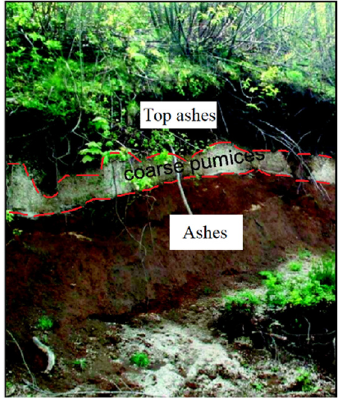
Figure 7. Soil profiles of the the Cervinara slope in southern Italy. Modified from [56].